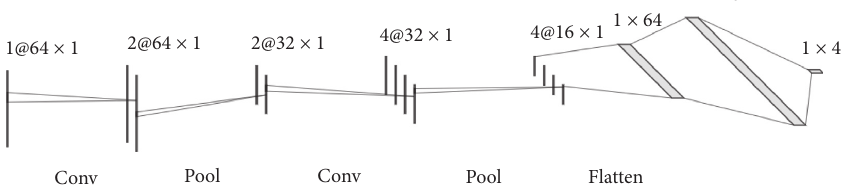
Figure 2: One-dimensional convolutional neural